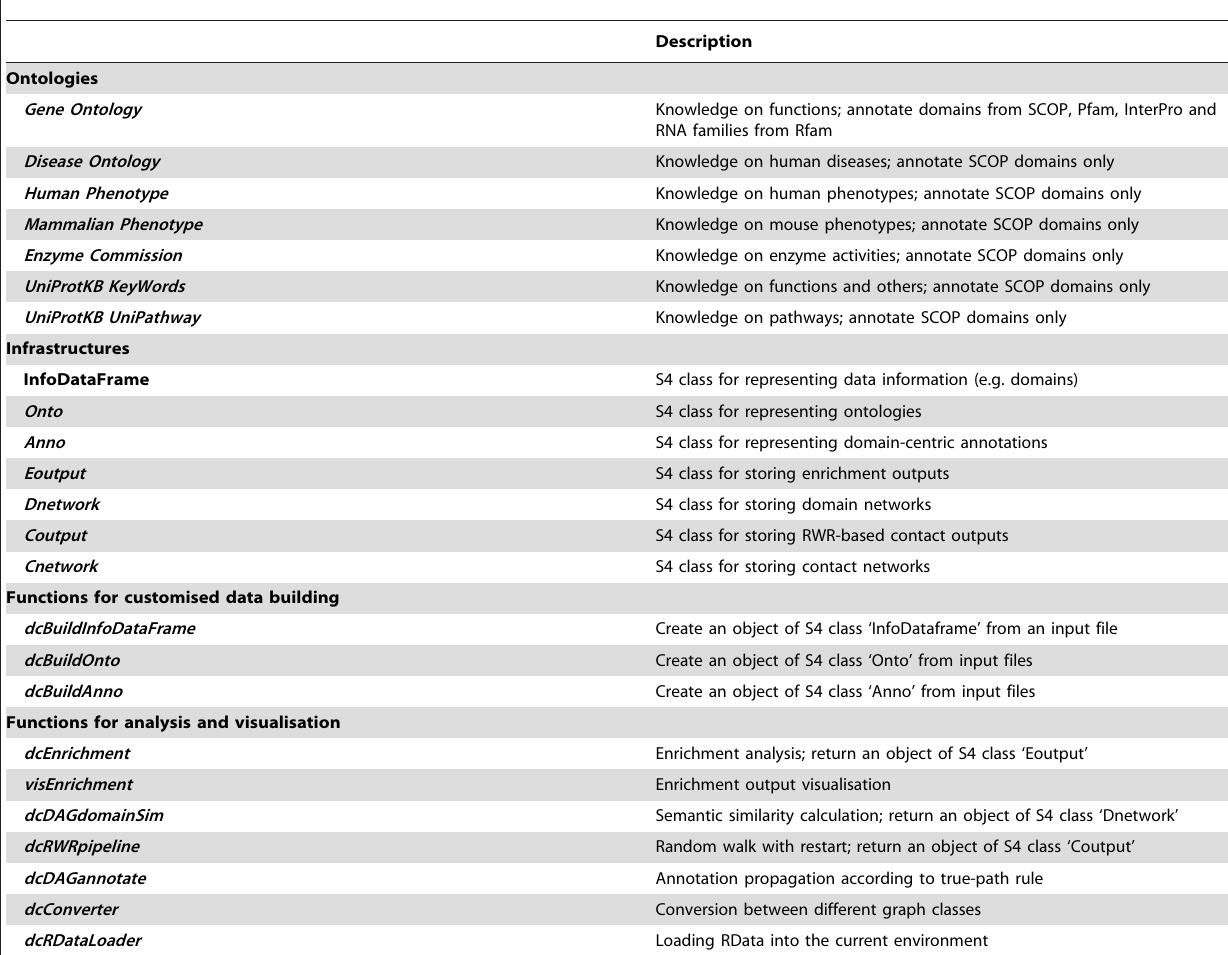
Table 1. A summary of ontologies, infrastructures and functions included in